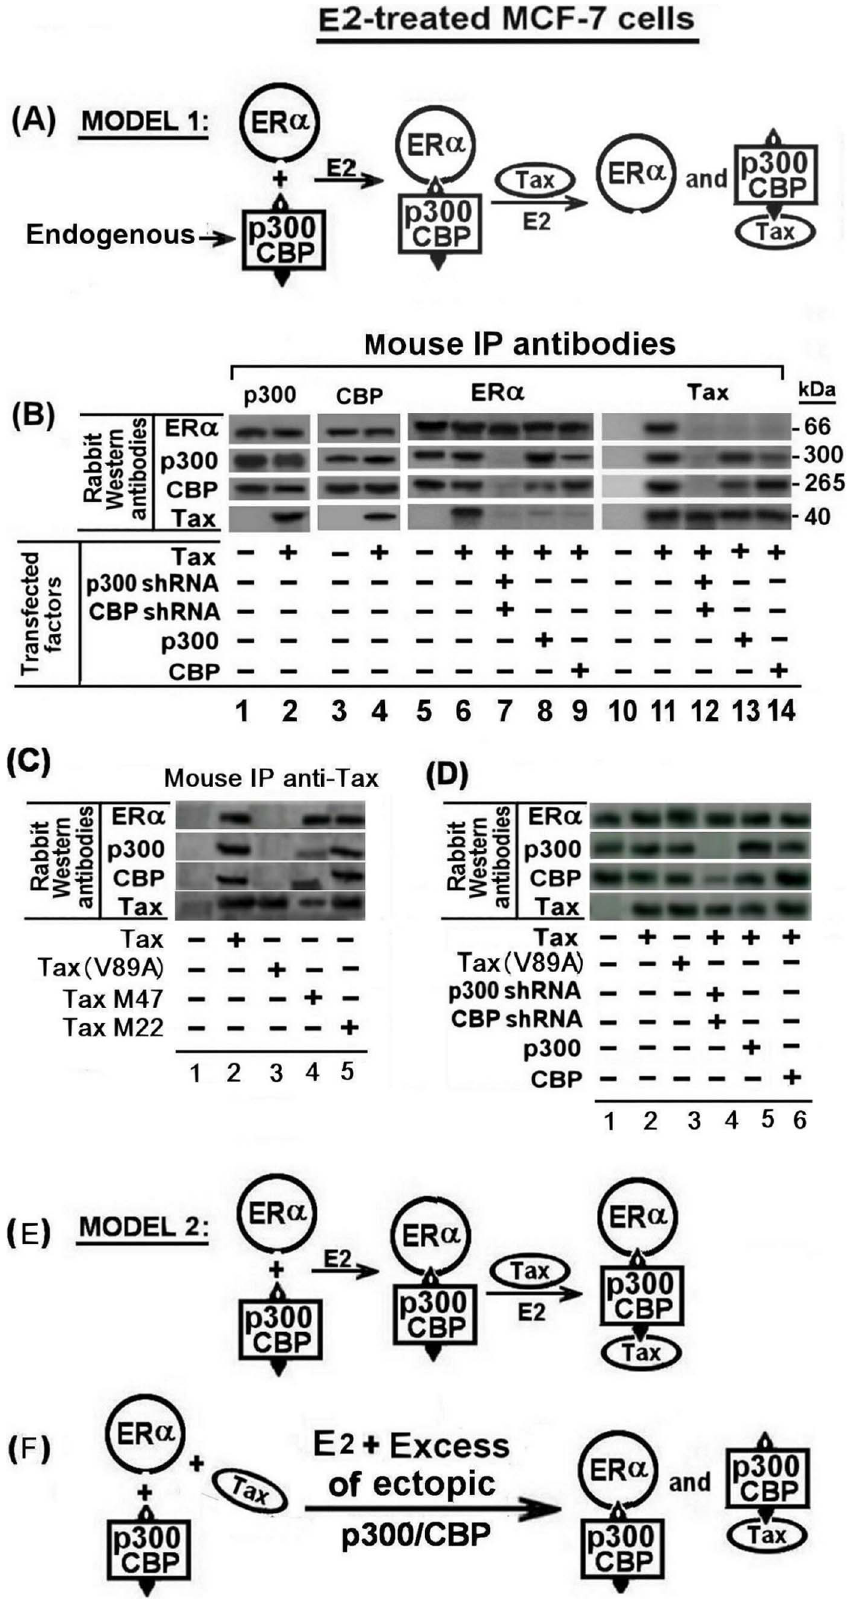
Figure 5. Tax physically associates with the ER a -CBP/p300 complex through binding to the recruited CBP/p300. (A) Schematical model 1 describing the formation of separate ER a -p300/CBP and Tax- p300/CBP complexes in E2 treated breast cells with or without Tax expression. (B)